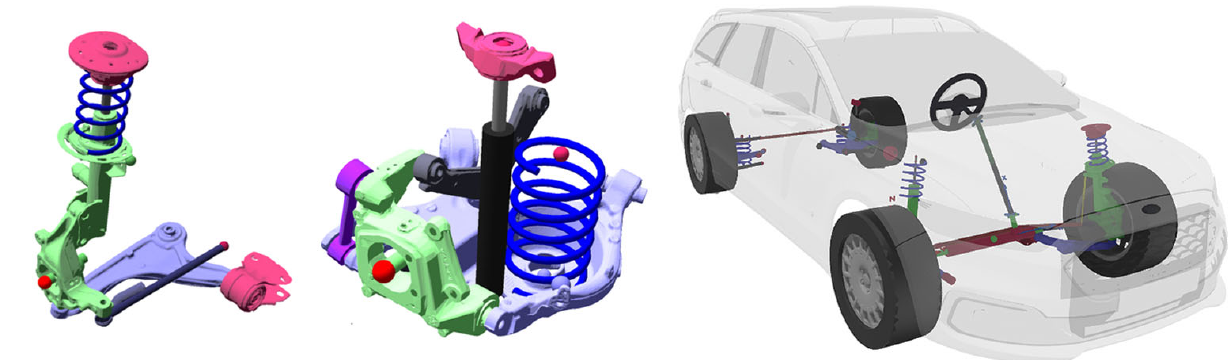
Figure 13. AFM’s photogrammetrically scanned front and rear axles ( left-hand side ) and the visualization of the high fidelity Modelica model ( right-hand side ). The vehicle and its environment are animated using the DLR Visualization 2 Library [26].